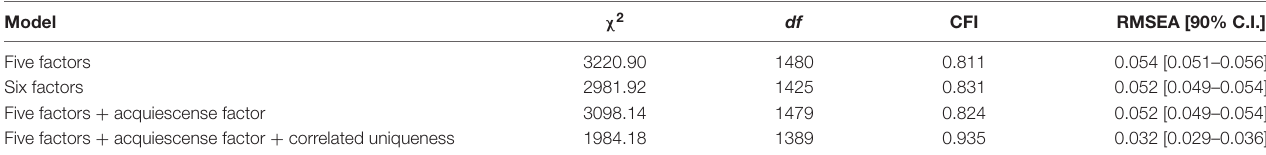
TABLE 8 | Fit indices for RI-EFA of scores from different models of the 60 item scores from the BFI-2. Model χ